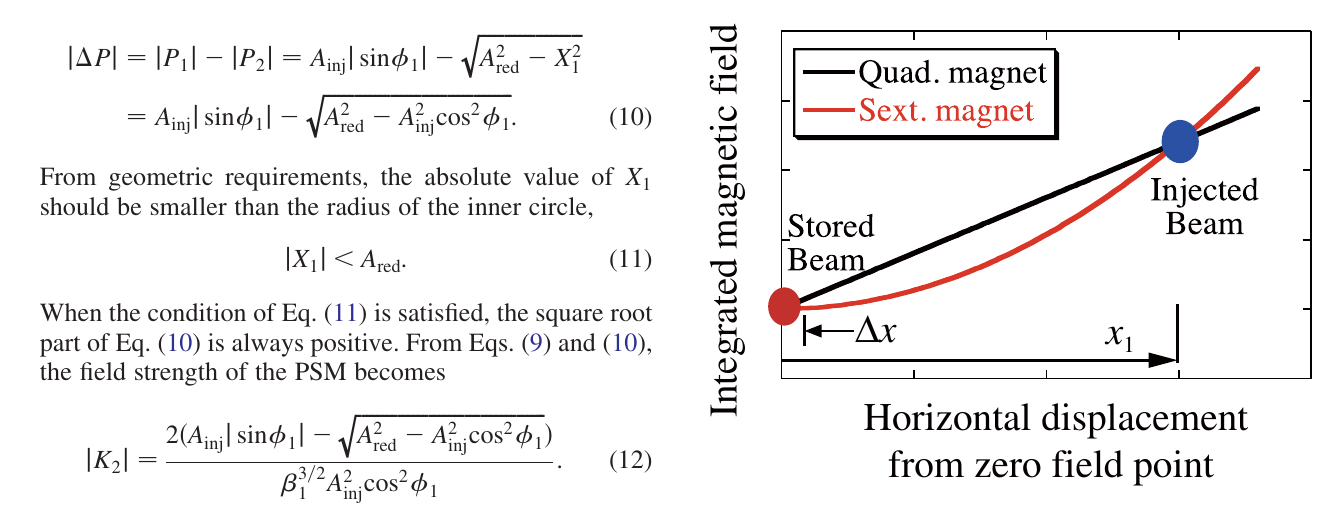
FIG. 3. (Color) Integrated magnetic fields of a PSM and a PQM as a function of horizontal displacement from the zero field point. To compare effects of the magnetic fields of the PSM and PQM on a stored beam, the field strengths of both magnets have the same value at the position of an injected beam orbit.